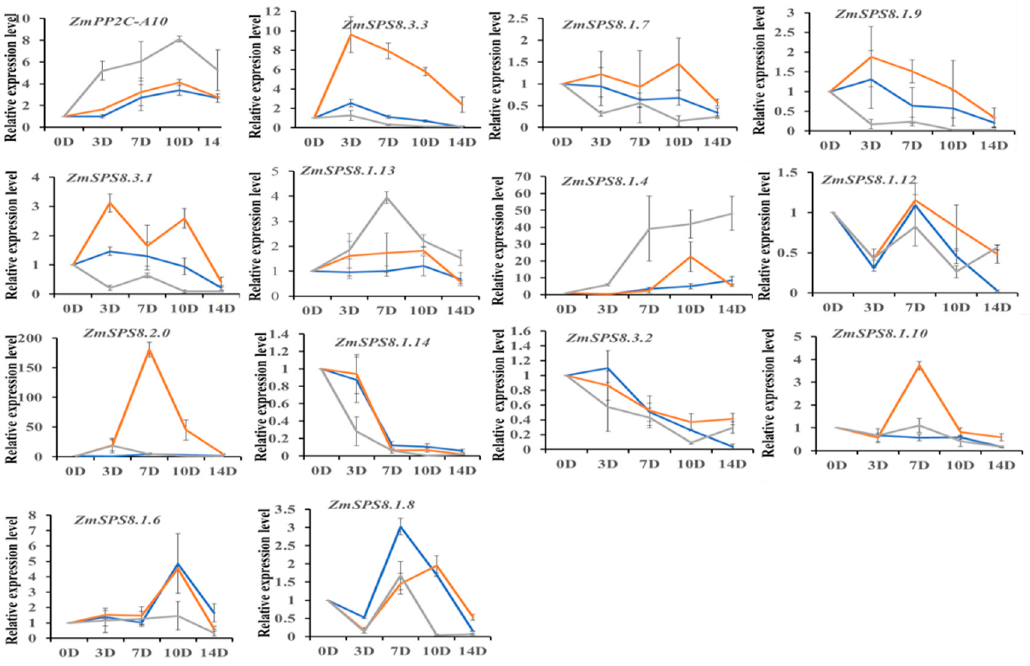
Figure 7. Expression pattern analysis of the maize serine peptidase S8 family genes under drought treatment by qRT-PCR. The x-axis is the time course of treatment, and seedlings were sampled at 0 (CK), 3, 7, 10, and 14 D after drought treatment, respectively. The y-axis shows the relative expression levels. Grey line: B73; Bule line: Zheng58; Orange line: